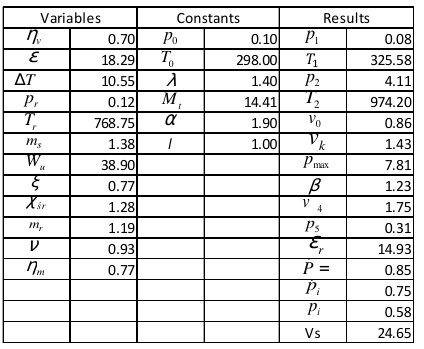
Table 4. Values of the variables and results for Vs = 0.023 m 3